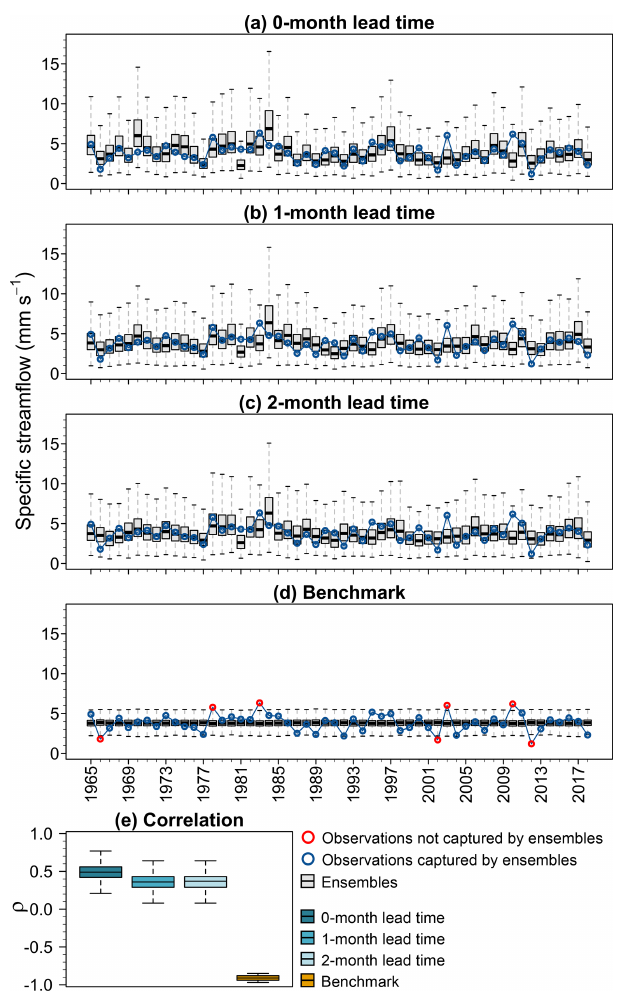
Figure 12. Time series of average projected spring maximum spe- cific streamflow (millimeters per day; hereafter mmd − 1 ), from the leave-1-year-out cross-validation for a (a) 0-month lead time, (b) 1- month lead time, (c) 2-month lead time, (d) the benchmark, and (e) the distributions of the Pearson correlation coefficient between the observed and the ensembles of the average projection spring maximum specific streamflow over all seven gauges for the different models. Blue and red points in panels (a) – (d) indicate when obser- vations are captured (or not) by the ensemble’s variability, respec- tively. Whiskers show the 95% credible intervals, boxes the show interquartile range, and horizontal lines inside the boxes show the median. Outliers are not displayed. All lead time models consider a Gaussian